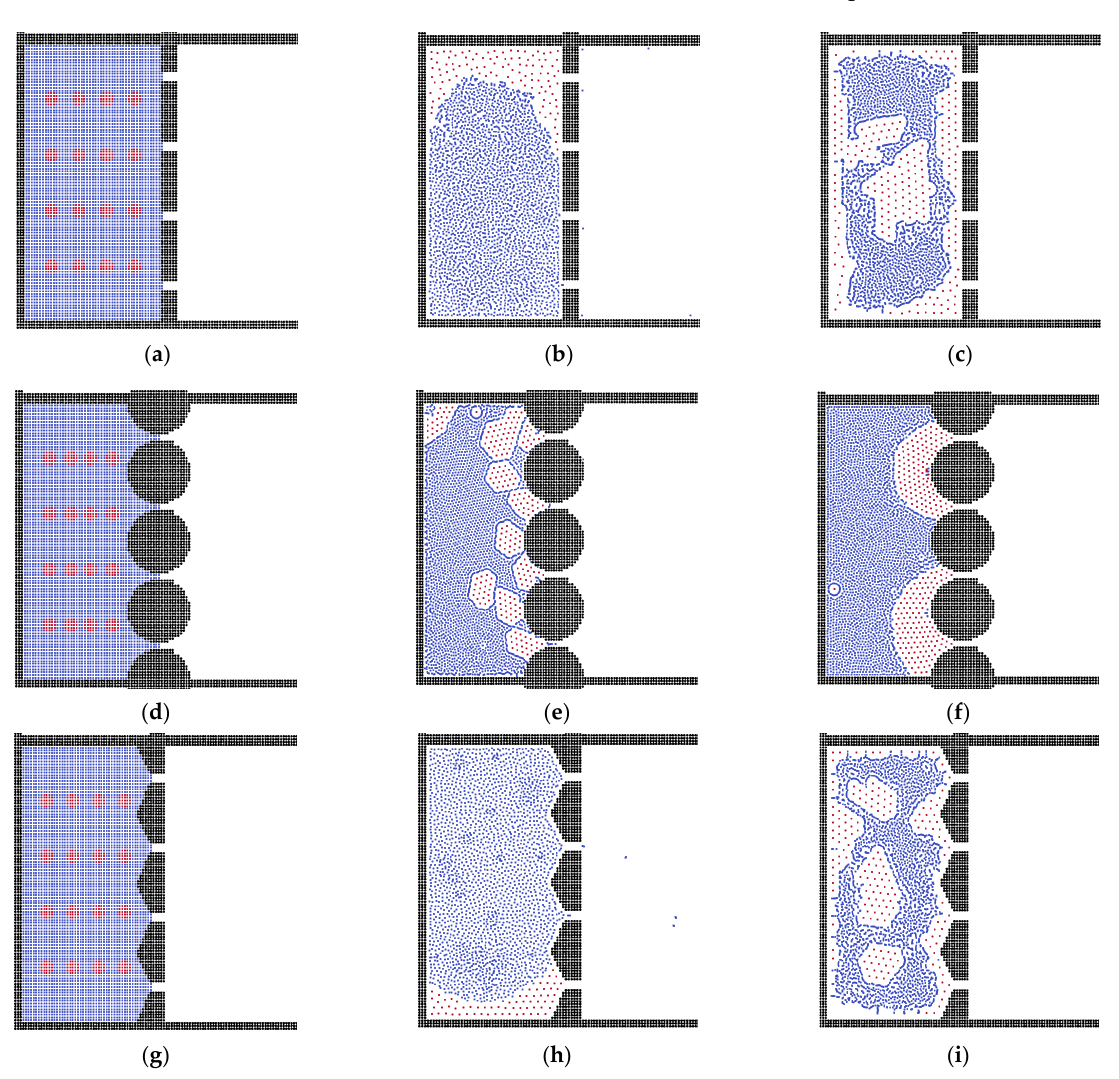
Figure 9. Results with different driving forces: ( a , d , g ) initial conditions of three different shape membrane systems; ( b , e , h ) controlled with 0.0005 m·s − 2 ; and ( c , f , i ) controlled with 0.0015 m·s − 2 .